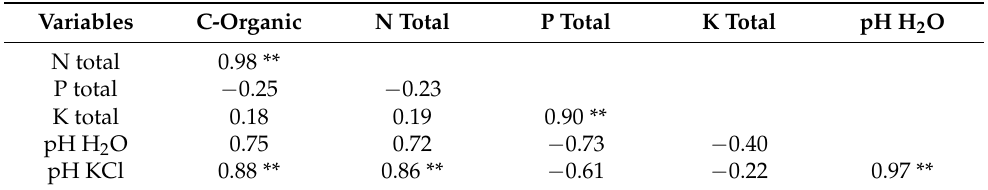
Table 5. Pearson coefficient correlation of several soil macronutrients and pH under kaffir lime canopy in four growing locations.